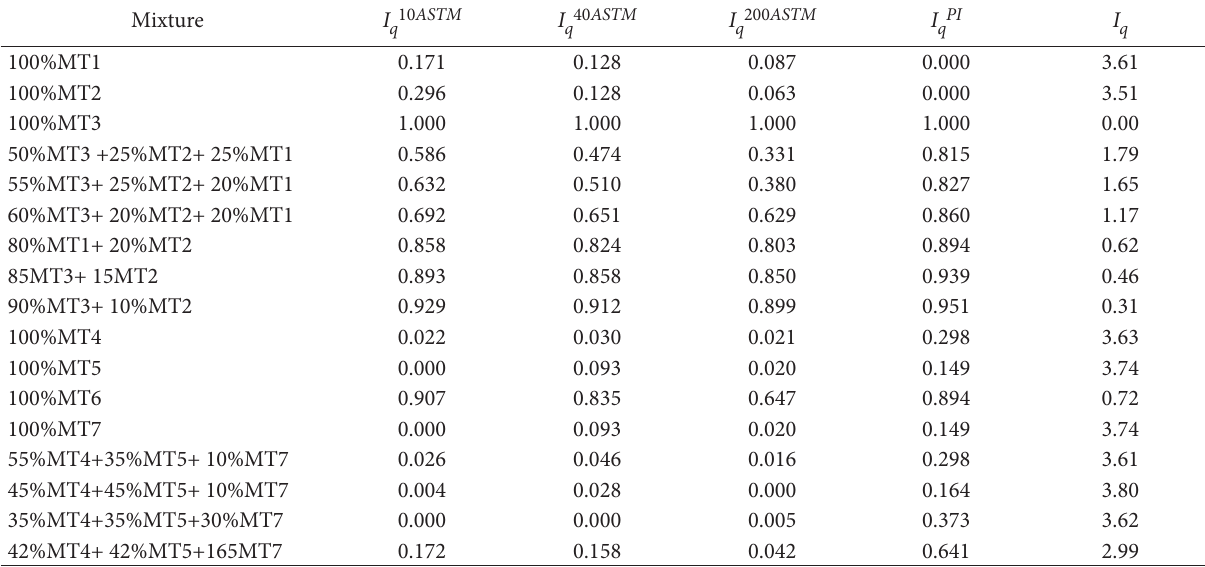
Table 3. I q index of designed mixtures to assess soil mechanical quality Mixture